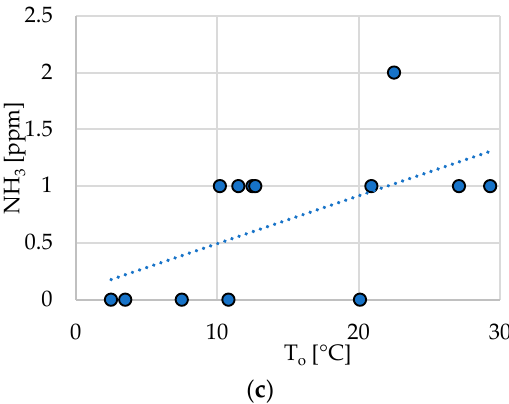
Figure 7. Correlation diagrams between odorant concentration in the fermentation preparation section of biogas plant A and measured microclimatic parameters, with regression lines: ( a ) R 2 = 0.96, ( b ) R 2 = 0.34, ( c ) R 2 = 0.33.